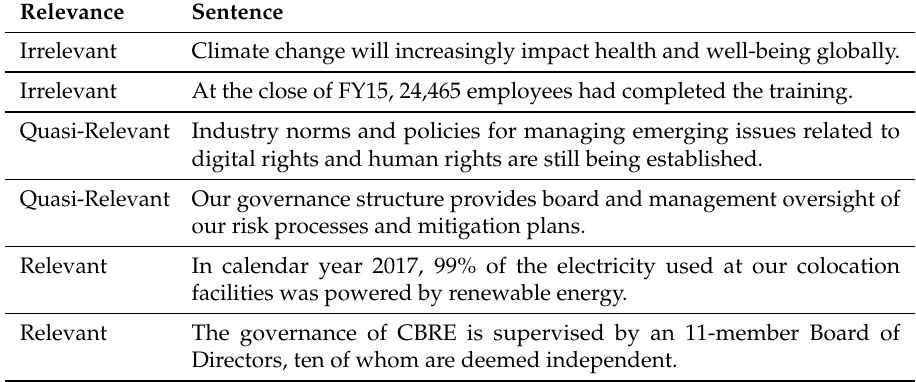
Table 2. Manual Annotation - sample sentences and their corresponding relevance.